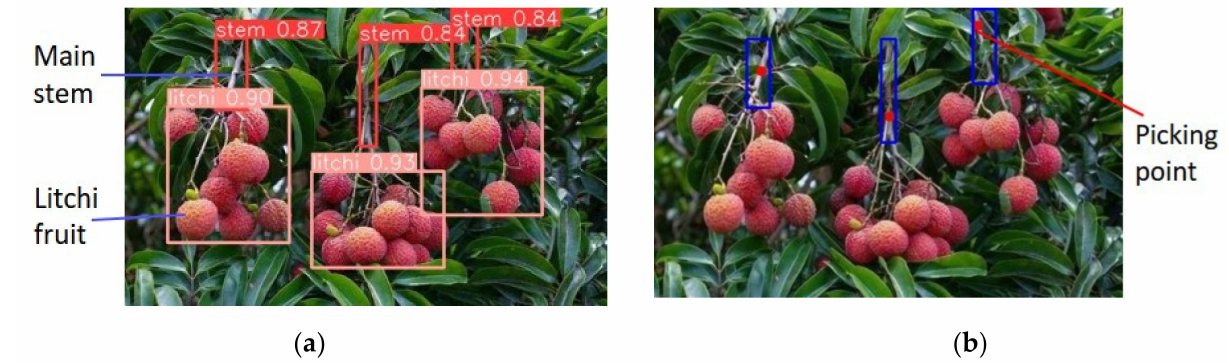
Figure 2. Detection results of main stem and fruit of litchi and location results of picking point. ( a ) Detection results of main stem and fruit of litchi; ( b ) location results of picking point.